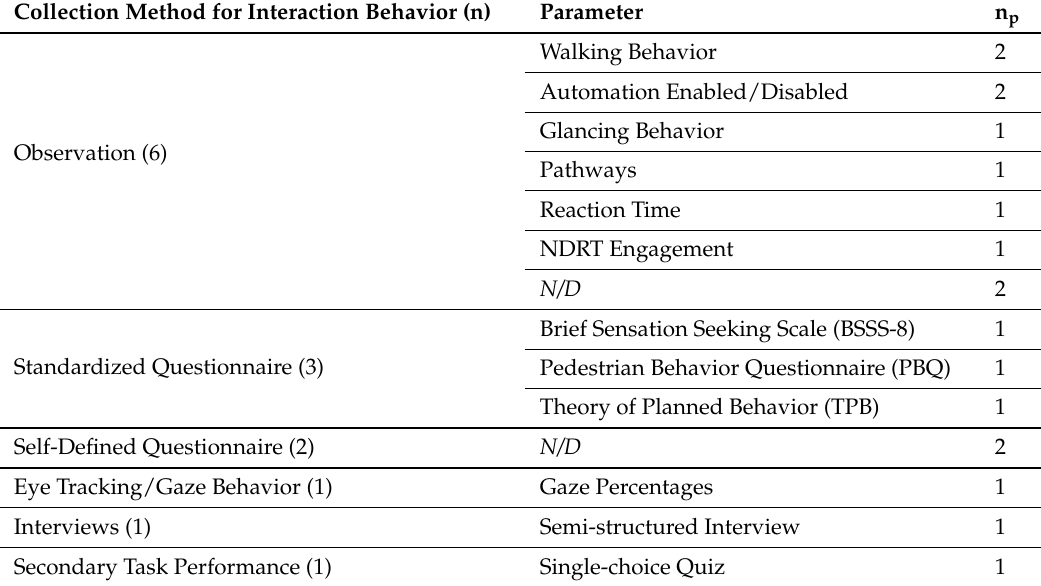
Table 9. Interaction Behavior collection methods and parameters.